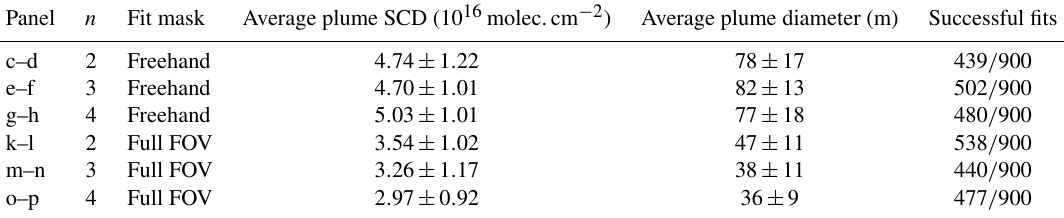
Gaussian fit routine. Figure 16i–p show the same